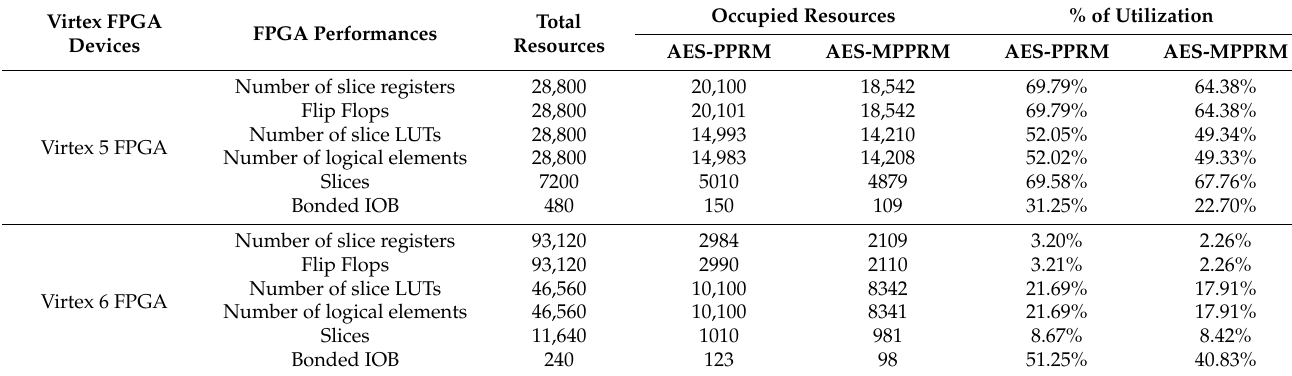
Table 5. Hardware utilization analysis of AES-MPPRM for Virtex FPGA devices. Virtex FPGA Devices